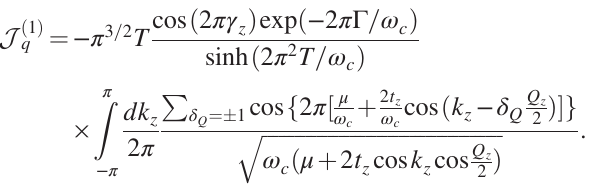
dependence of the z